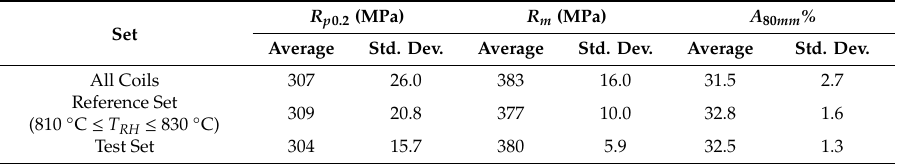
Table 6. Results of the o ffl ine tests for Steel Code B and thickness range 3 (0.9–1.1 mm).